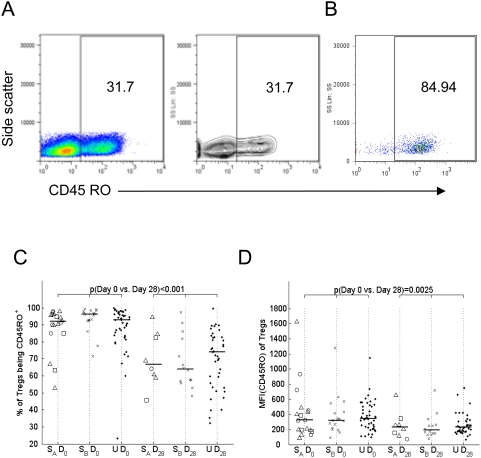
Tregs display an activated memory phenotype during acute disease.(A) Defining the gate for CD45RO staining on CD3+ PBMC using the contour display. (B) CD3+CD4+FOXP3+ CD127−/low PBMC displayed according to CD45RO expression using the gate defined in (A). (C) percentage of CD3+CD4+FOXP3+ CD127−/low PBMC expressing CD45RO. (D) Median Fluorescence Intensity (MFI) for CD45RO staining on CD3+CD4+FOXP3+ CD127−/low PBMC. Symbols, bars and p-values as defined in Figure 1.